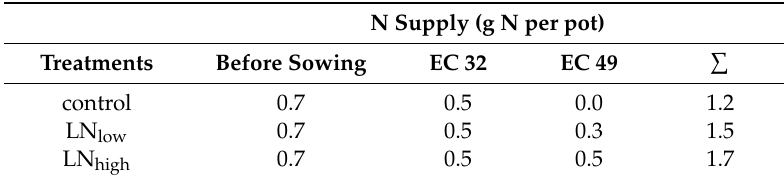
Table 1. Timing and amount of N-fertilization of the three treatments (g N pot − 1 , provided as ammonium